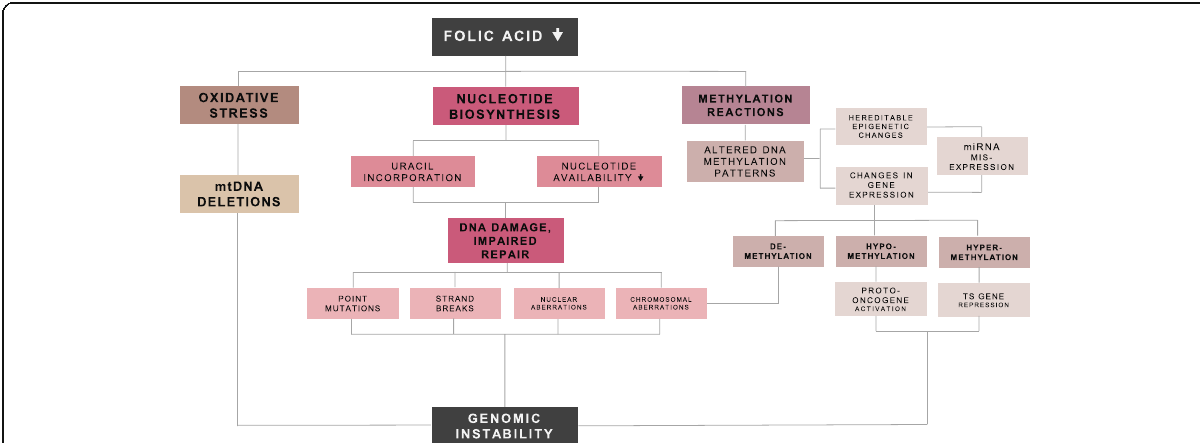
Fig. 1 The relationship between folic acid deficiency and the genomic instability. Low levels of folic acid interfere with the normal biological functions of the cell, compromising the genomic stability for both nuclear and mitochondrial DNA. Folic acid deficiency affects the synthesis of nucleotides, causing DNA damage that cannot be repaired efficiently because of an overall decrease in the nucleotide availability. As methyl donors, the unavailability of folates can alter DNA methylation, causing changes in gene expression and compromising the integrity of chromosomes. Deprivation of folic acid also causes oxidative stress in the cell with consequences affecting the integrity of mitochondrial